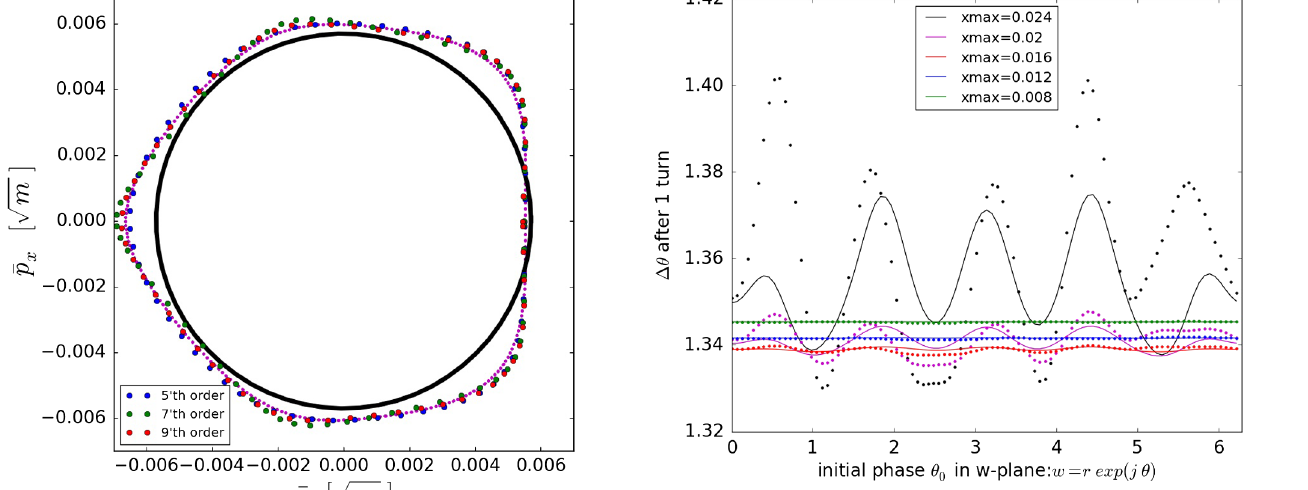
at fifth, x j phase space x